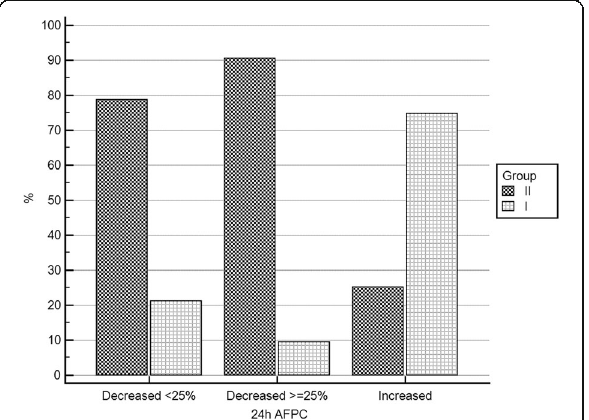
Fig. 2 Patterns of the 24-h AFPC in both